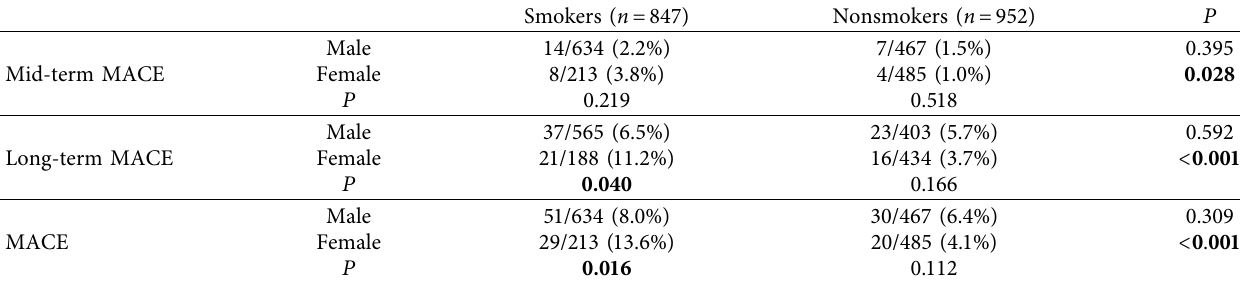
Figure 1: Hazard rate for interaction of sex and smoking. After adjusting other risk factors including age, hDM, hHTN, and hHLP, female patients with smoking remained at higher risk than male patients with smoking. HR for female nonsmokers, male nonsmokers, and male smokers versus female smokers were (0.360, CI: 0.203–0.637), (0.562 CI: 0.337–0.937), and (0.597 CI: 0.376–0.948), respectively. Table 4: MACE incidence in mid-tem, long term, and total between smokers and